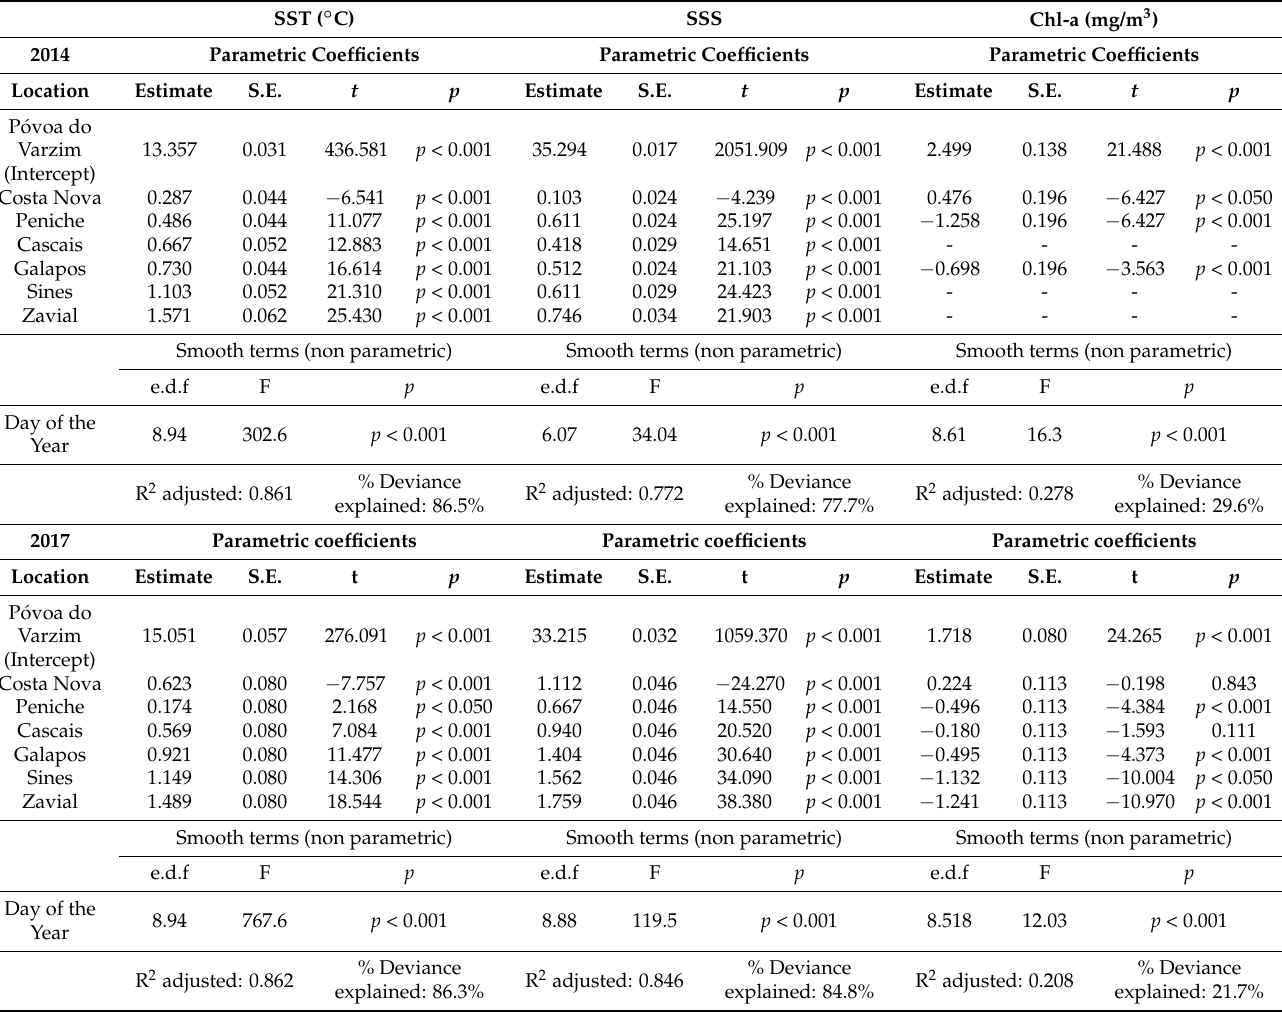
Table 1. Structure of the General Additive Model describing Sea Surface Temperature ( ◦ C), Sea Surface Salinity (SSS) and Chlorophyll-a concentration (mg/m 3 ) variability along the coastline from January to May 2014 and January to June 2017. S.E.: standard error; e.d.f.: estimated degrees of